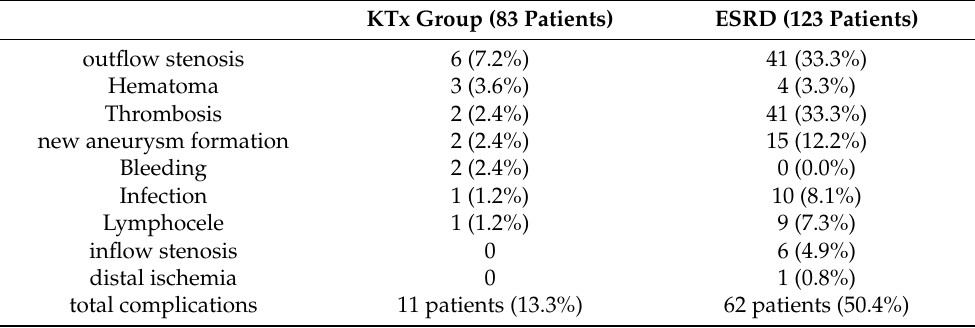
Table 3. Complications after dialysis fistula reconstruction in kidney transplant recipients (KTx group) and dialyzed patients (ESRD